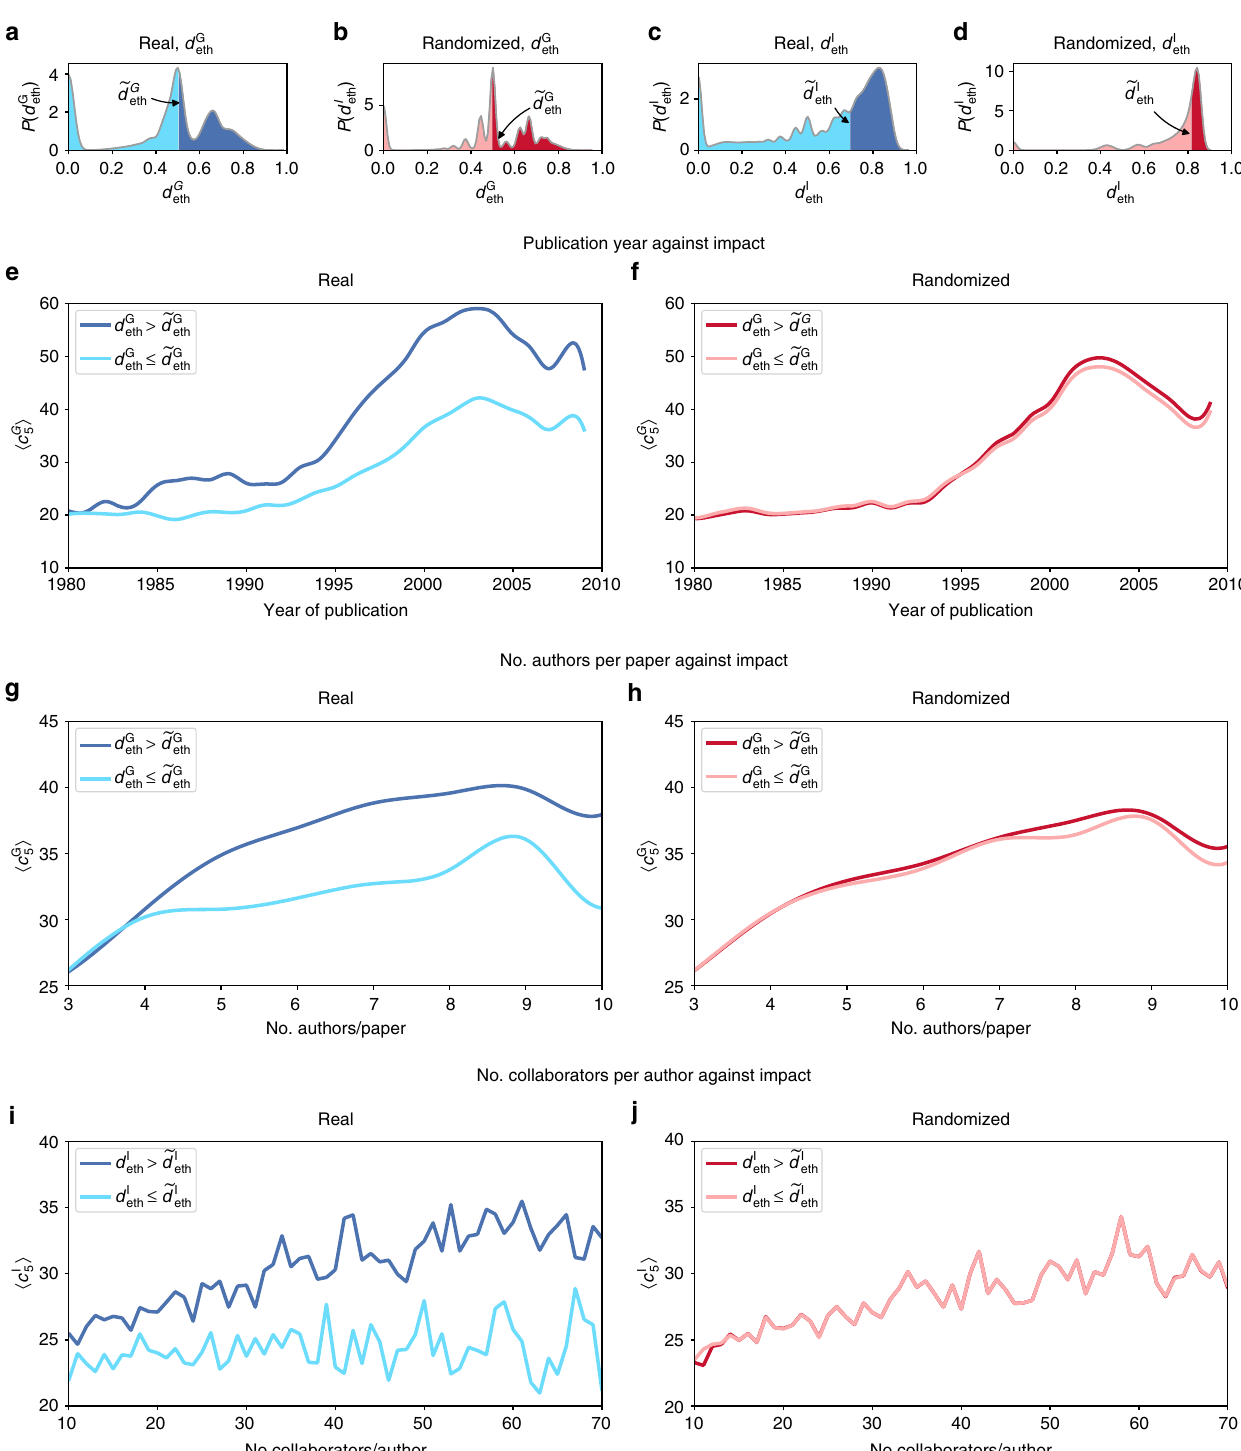
in real data. Papers were partitioned into two categories: diverse eth ~ d G ~ d G ) and non-diverse (highlighted in the lighter tones, with d G ), where the tilde denotes the median. (cid:2) > eth eth eth eth instead of d G . e h c G against publication year in real 5 i eth eth against number of authors per paper in real data. h The same as ( g ), but for randomized data. i h c I 5 i